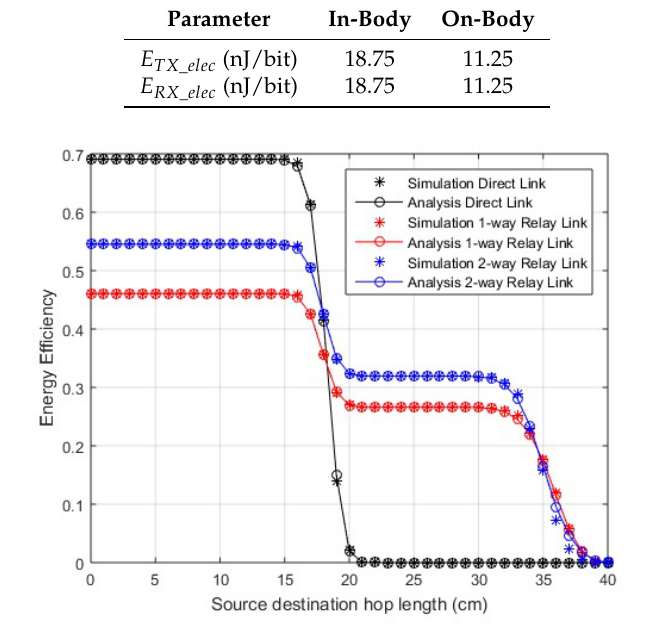
Table 3. Transceiver specifications.